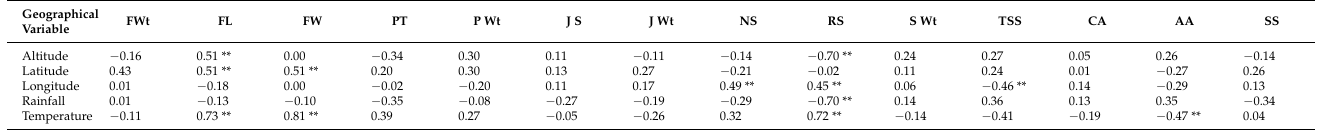
Table 5. Correlation coefficient between geographical variable with morphological and nutrient contents of C. sinensis .